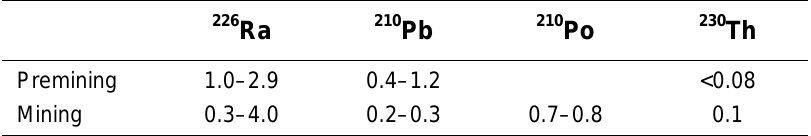
Radionuclide Activity Concentrations (Bq kg –1 Fresh Weight) for